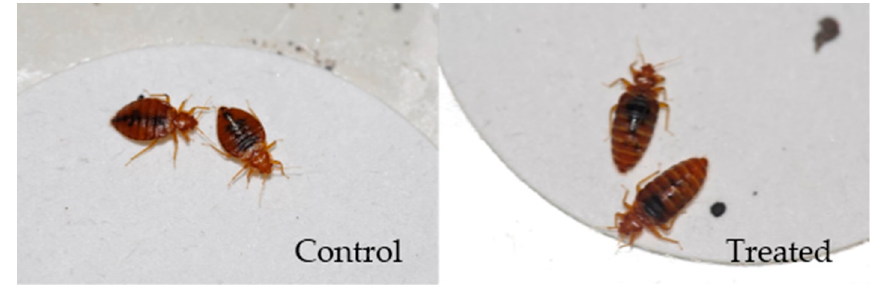
Figure 2. Bed bug males survived at one week after ingesting untreated rabbit blood and rabbit blood containing 40 ng/mL moxidectin.